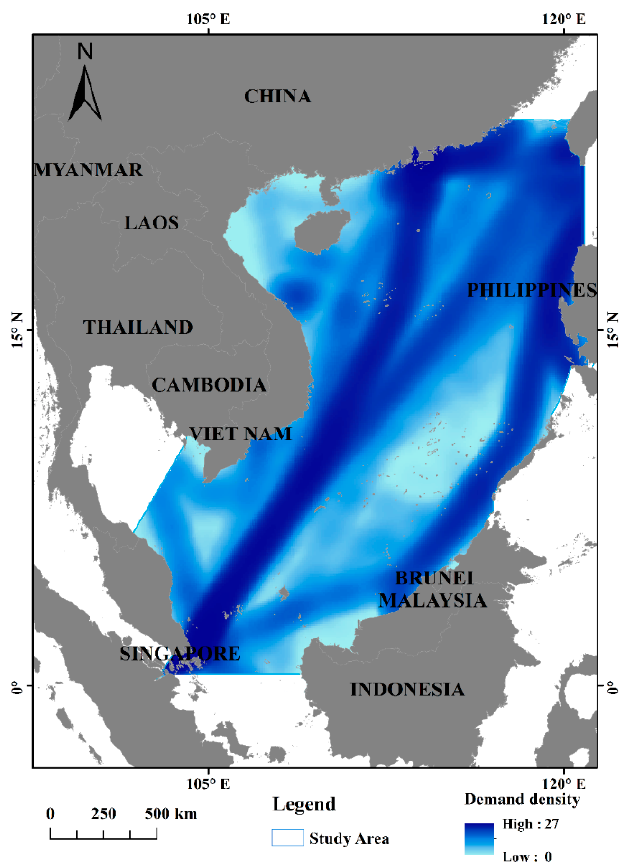
Figure 7. The potential demand density in the South China Sea.